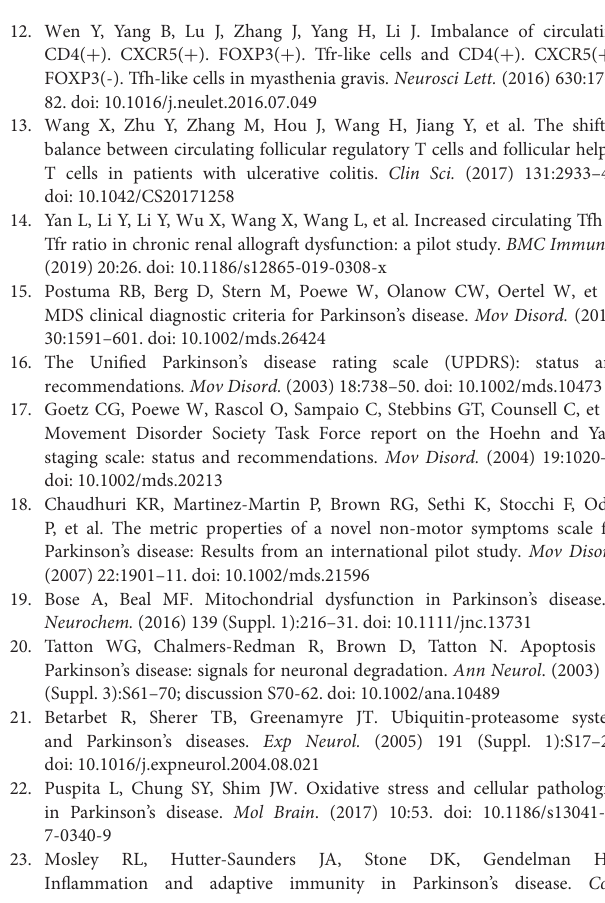
Supplementary Figure 1 | The comparison of the UPDRS-III score between early PD group and middle-advanced PD group. Supplementary Figure 2 | The correlation of the cTfh/cTfr ratio and NMSS in PD patients after